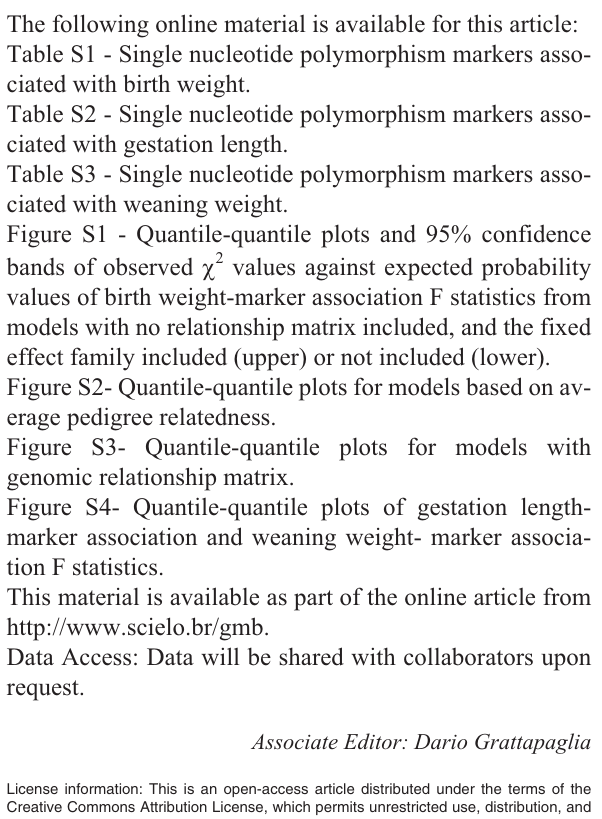
ciated with birth weight. Table S2 - Single nucleotide polymorphism markers asso- ciated with gestation length. Table S3 - Single nucleotide polymorphism markers asso- ciated with weaning weight. Figure S1 - Quantile-quantile plots and 95% confidence bands of observed (cid:9) 2 values against expected probability values of birth weight-marker association F statistics from models with no relationship matrix included, and the fixed effect family included (upper) or not included (lower). Figure S2- Quantile-quantile plots for models based on av- erage pedigree relatedness. Figure S3- Quantile-quantile plots for models with genomic relationship matrix. Figure S4- Quantile-quantile plots of gestation length- marker association and weaning weight- marker associa- tion F